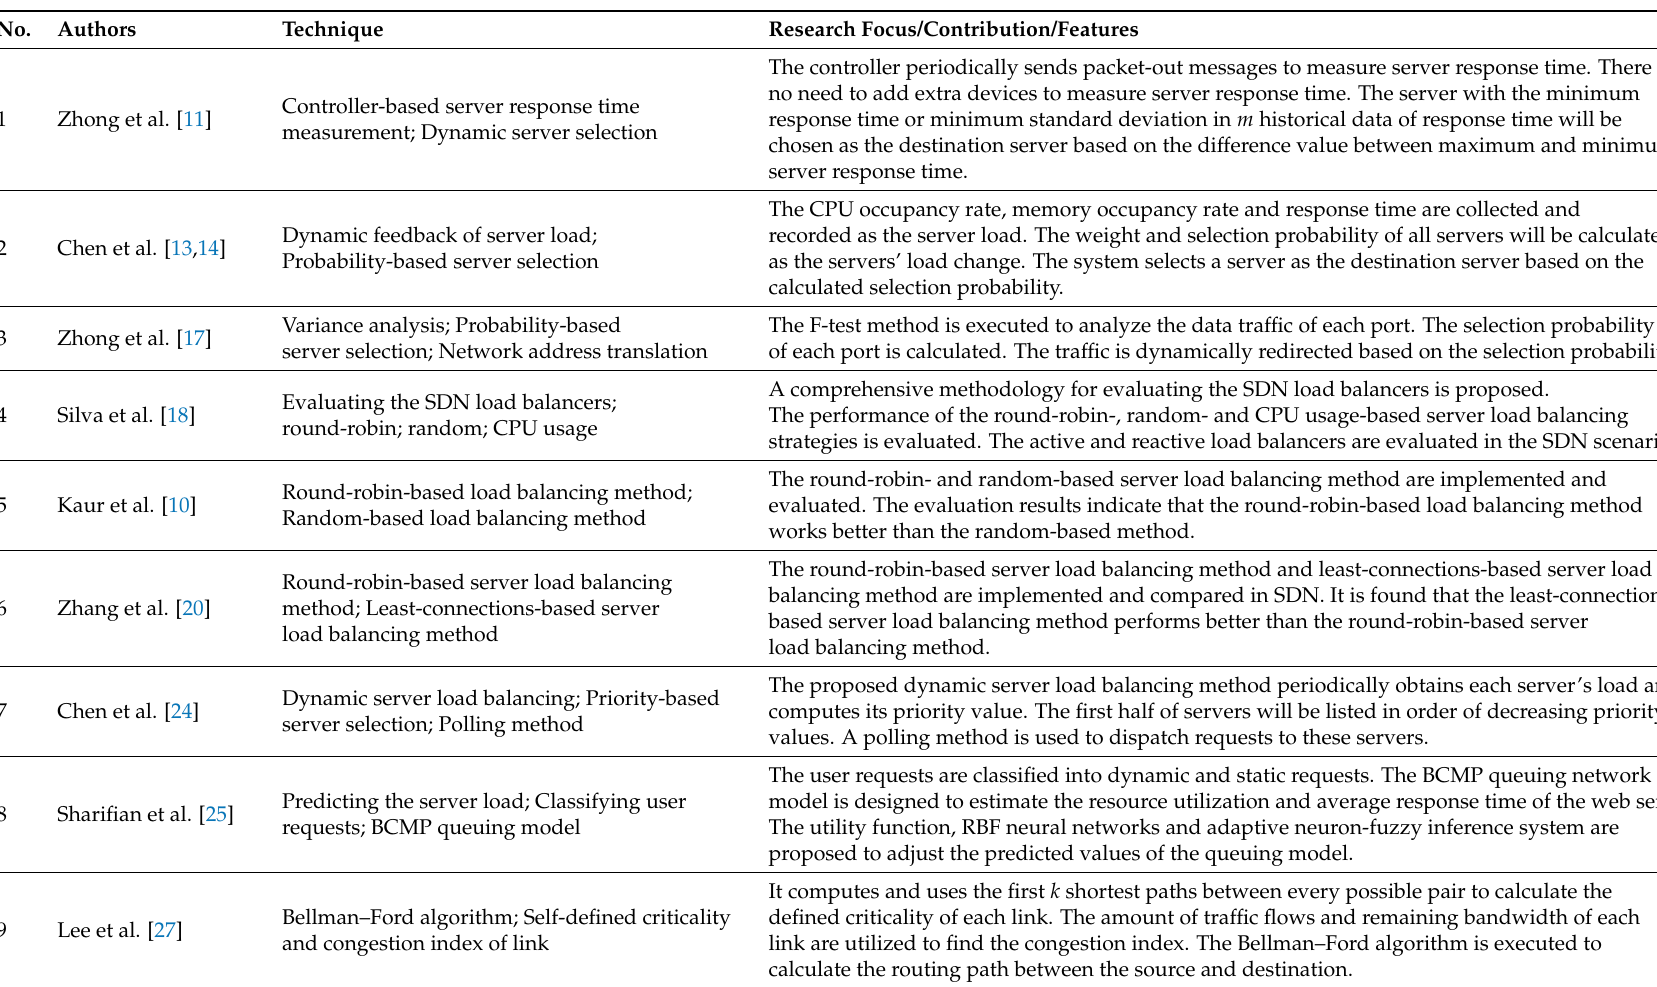
Table 1. Main differences between the proposed method and the exiting methods. BCMP, Baskett, Chandy, Muntz and